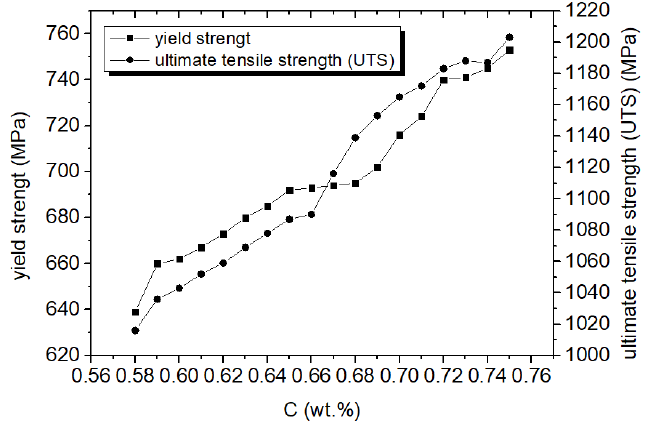
Figure 5. The tensile strength of the rim varies with C content.